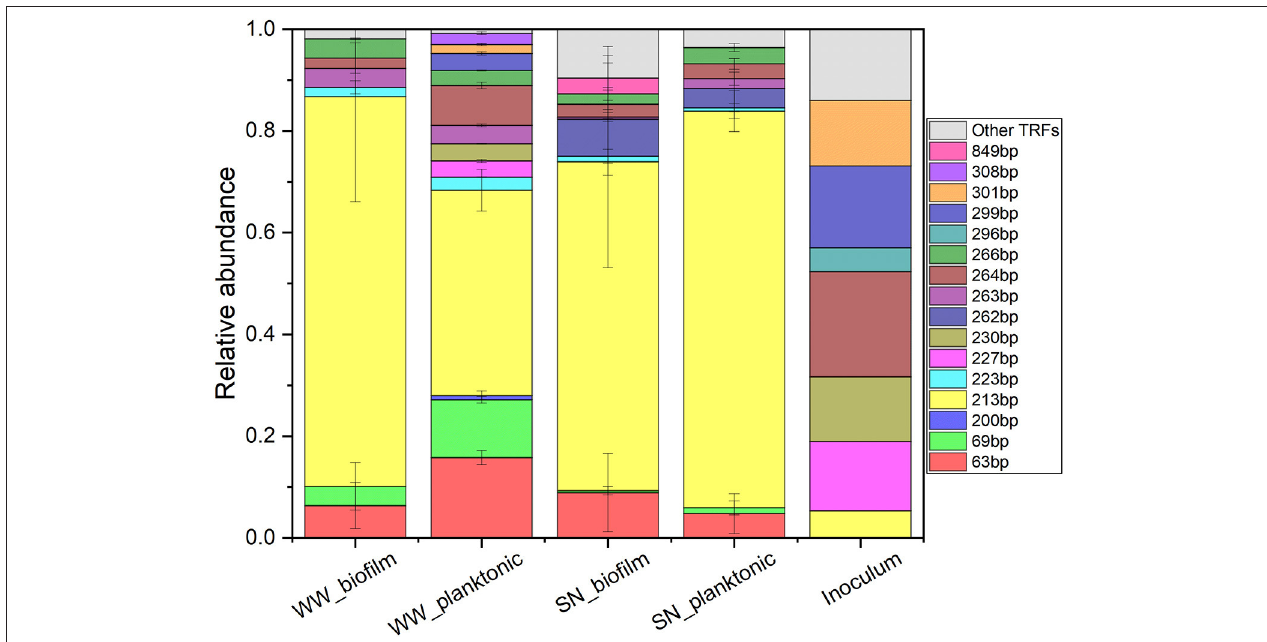
FIGURE 2 | Microbial community analysis of anode biofilms and liquid phase of bioelectrochemical systems sampled at the end of batch cultivation and of original waste water used as inoculum. 16S rRNA genes were analyzed via TRFLP using the restriction enzyme Hae III. WW and SN indicate experiments using raw waste water and supernatant, respectively, as inoculum and feed. WW: n = 3, SN that is pooled samples of SN 1 and SN2: n = 5, Inoculum: n = 1, error bars represent standard